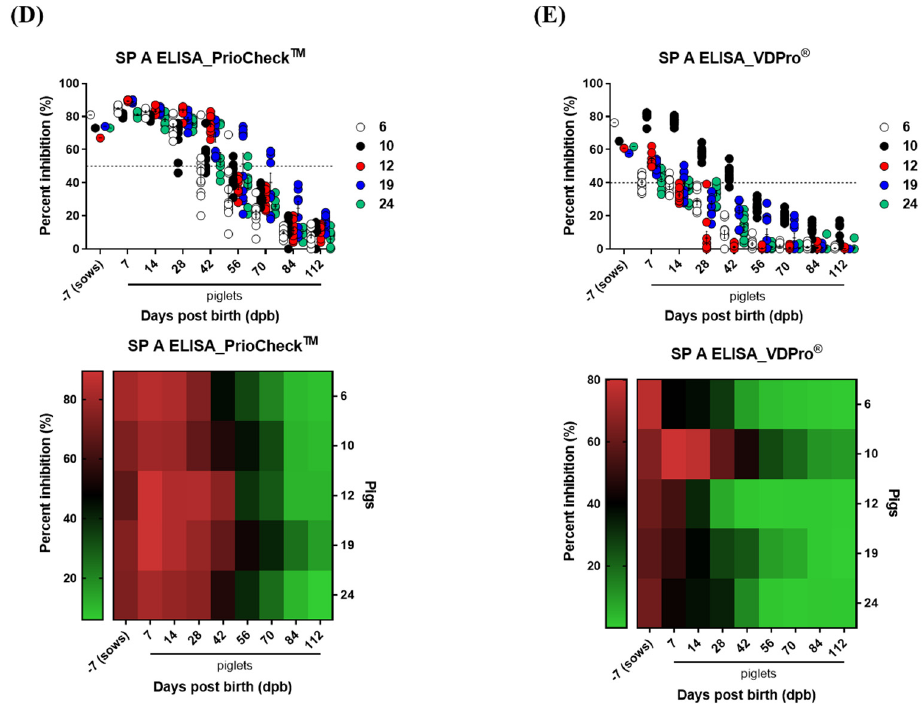
Figure 1. Age-dependent dynamics of maternally derived antibodies (MDA) in the sera of sows and piglets determined via SP O, A ELISA. To understand the properties of MDAs, five sows and 10 piglets from each sow were screened. For sows, blood was collected 7 days before farrowing. For the piglets born to sows, blood was collected on 7, 14, 28, 42, 56, 84, and 112 days post-birth. Serum antibody titer was determined via SP O, A ELISA using the PrioCheck TM kit and VDPro ® kit. Data are presented as the mean ± SEM of triplicate measurements ( n = 5 for sows and 10 piglets/sow). Data are shown in scatter plots and heat maps. The black dotted line represents the threshold of antibody positive (+) or negative ( − ). ( A – E ) represent: ( A ) Strategy for this study; ( B ) SP O ELISA determined using the PrioCheck TM kit; ( C ) SP O ELISA determined using the VDPro ® kit; ( D ) SP A ELISA determined using the PrioCheck TM kit; ( E ) SP A ELISA determined using the VDPro ® kit.